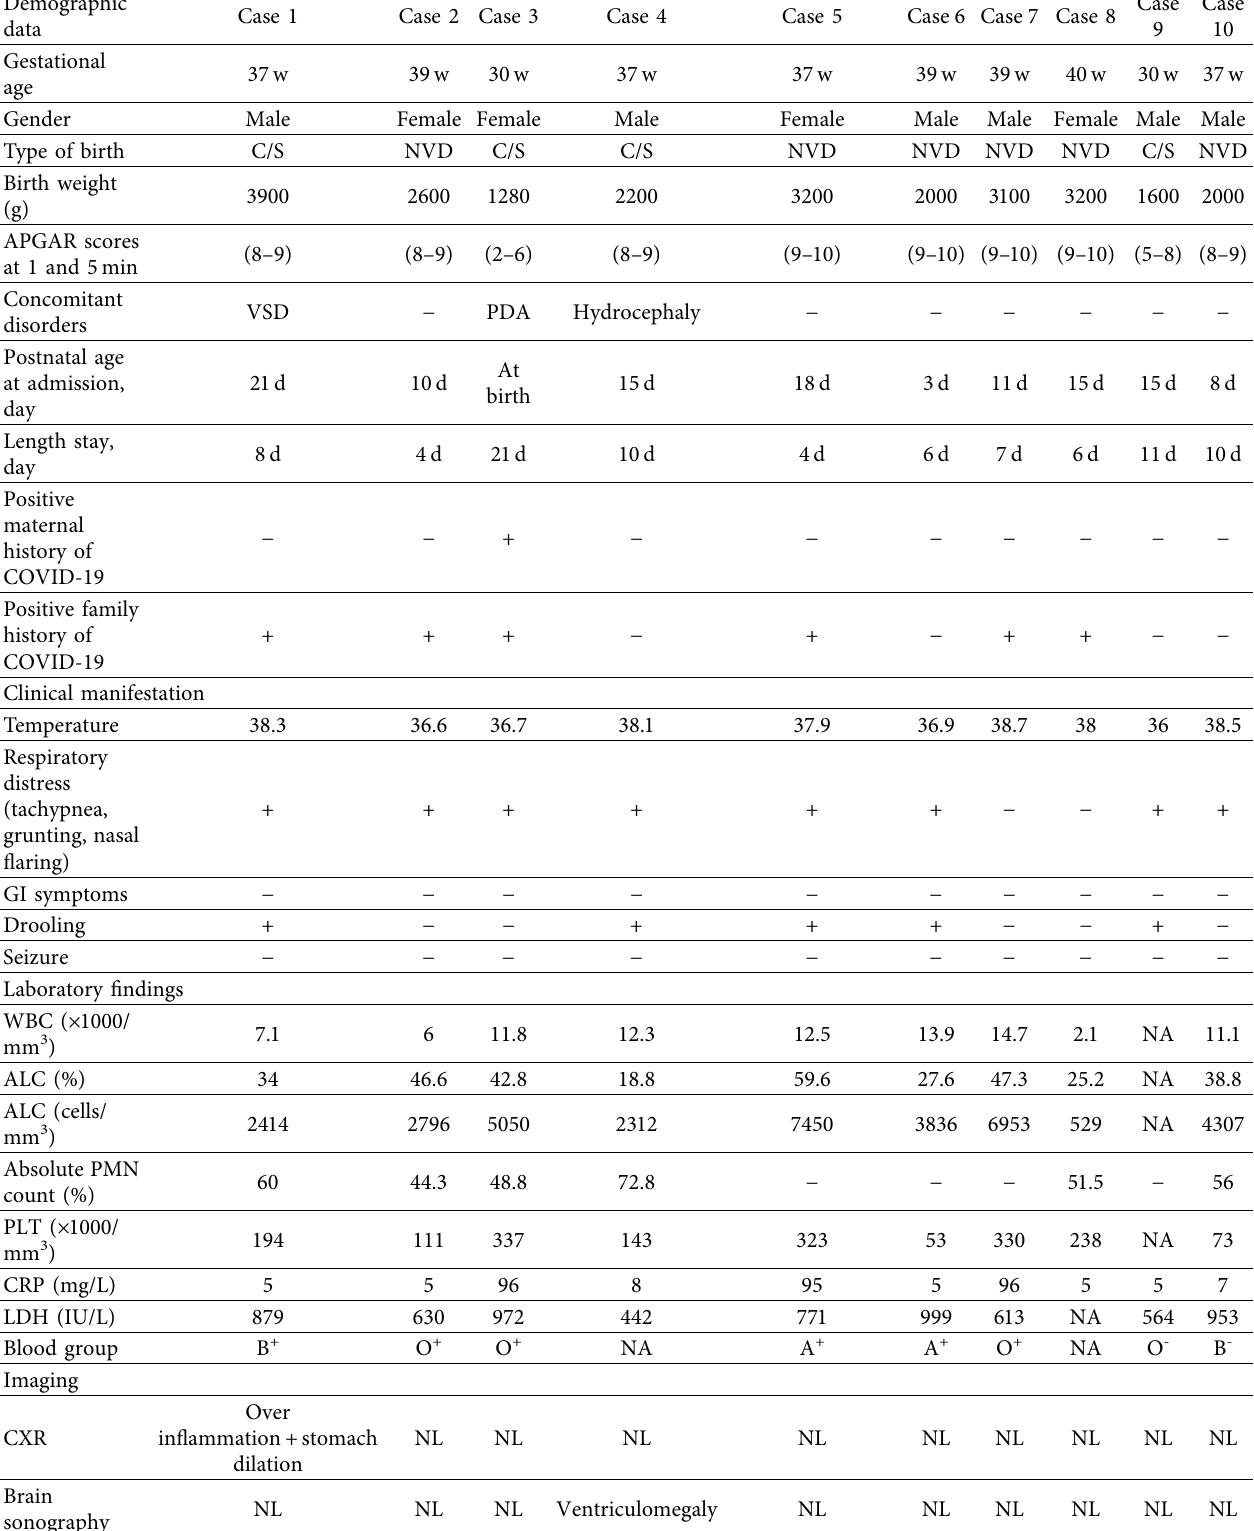
Table 1: Demographic and characteristic data of neonates infected with